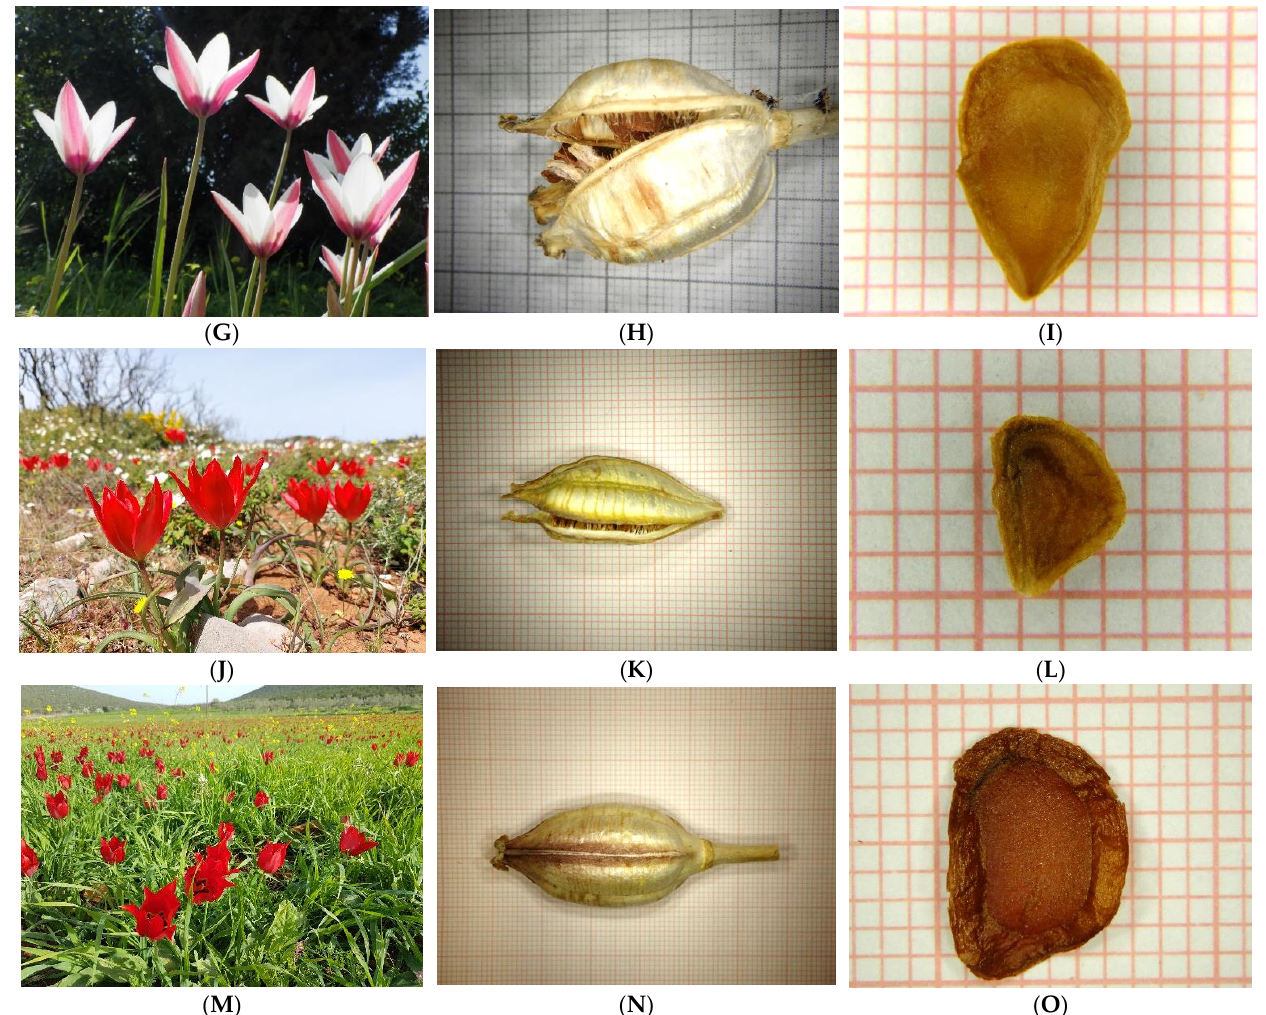
Figure 9. Flowering individuals, mature capsules, and seeds of wild-growing Tulipa australis ( A , B , and C , respectively), Tulipa bakeri ( D , E , and F , respectively), Tulipa clusiana ( G , H , and I , respectively), Tulipa goulimyi ( J , K , and L , respectively), and Tulipa undulatifolia ( M , N , and O , respectively) collected from Greece.